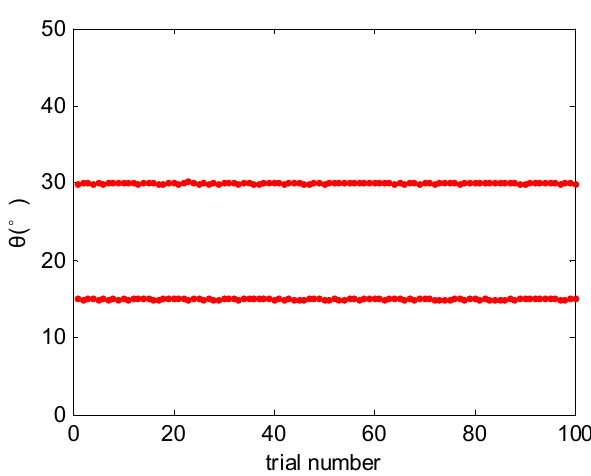
Figure 2. DOA estimation results over 100 trials (SNR = 0 dB).